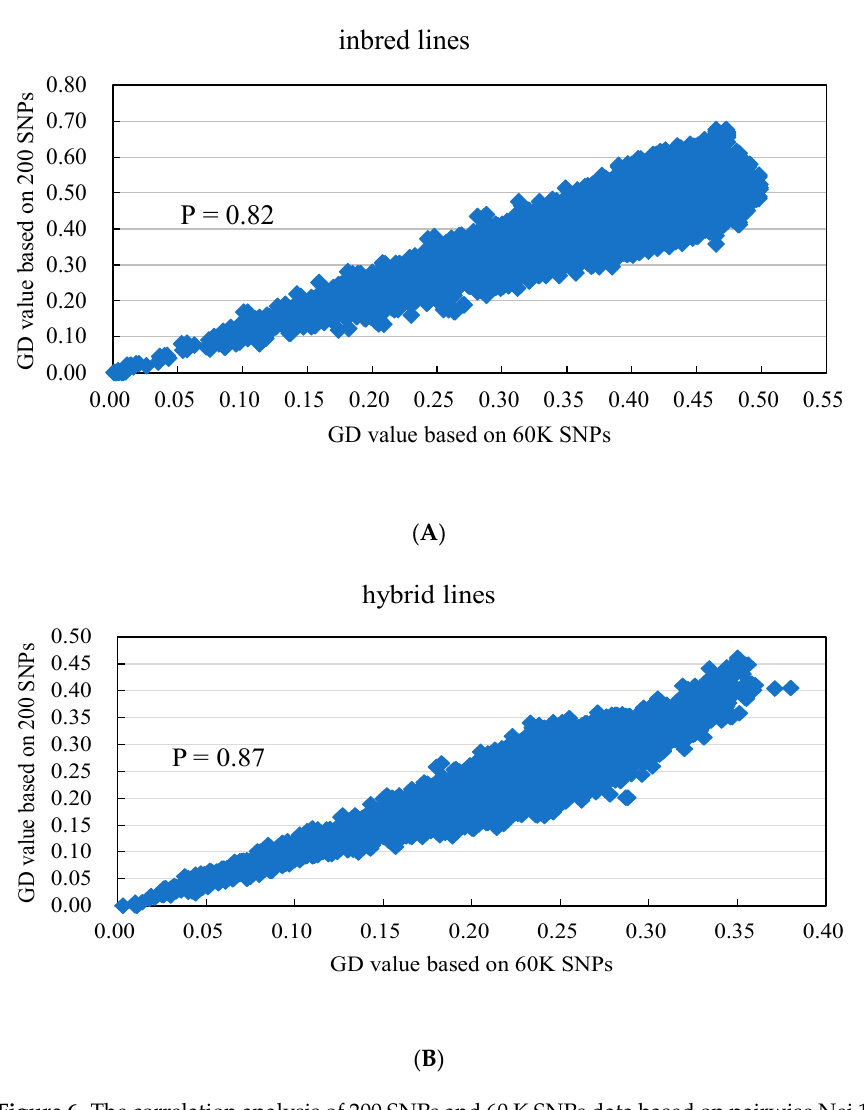
Figure 6. The correlation analysis of 200 SNPs and 60 K SNPs data based on pairwise Nei 1973 genetic distances (GD) of 329 inbred lines ( A ) and 221 hybrid lines ( B ). P is Pearson correlation coefficient.